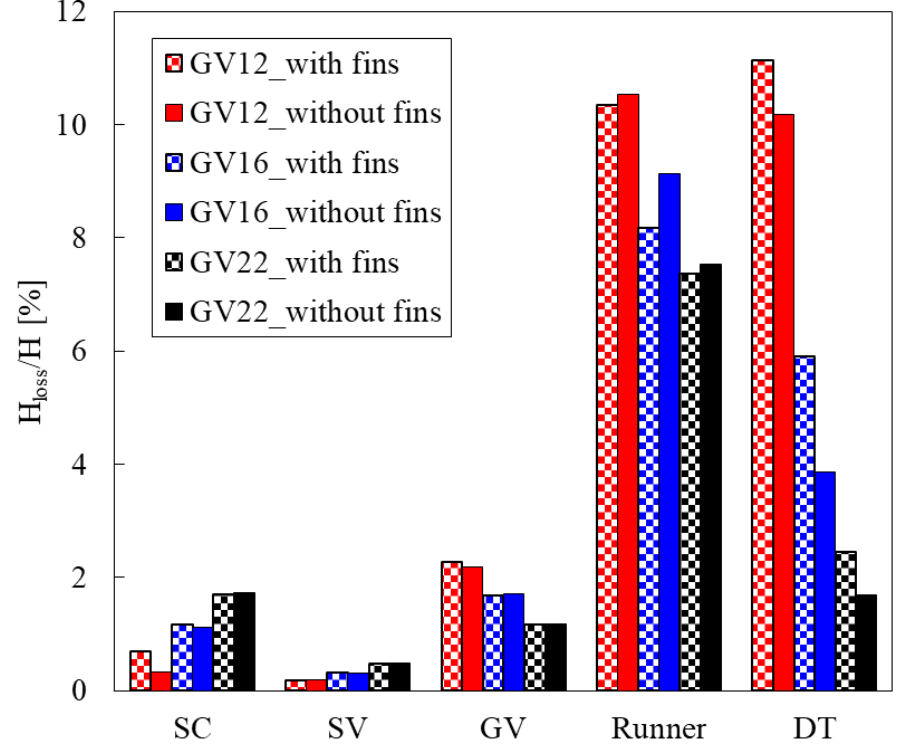
Figure 6. Head loss distribution in the main components of the Francis turbine model.